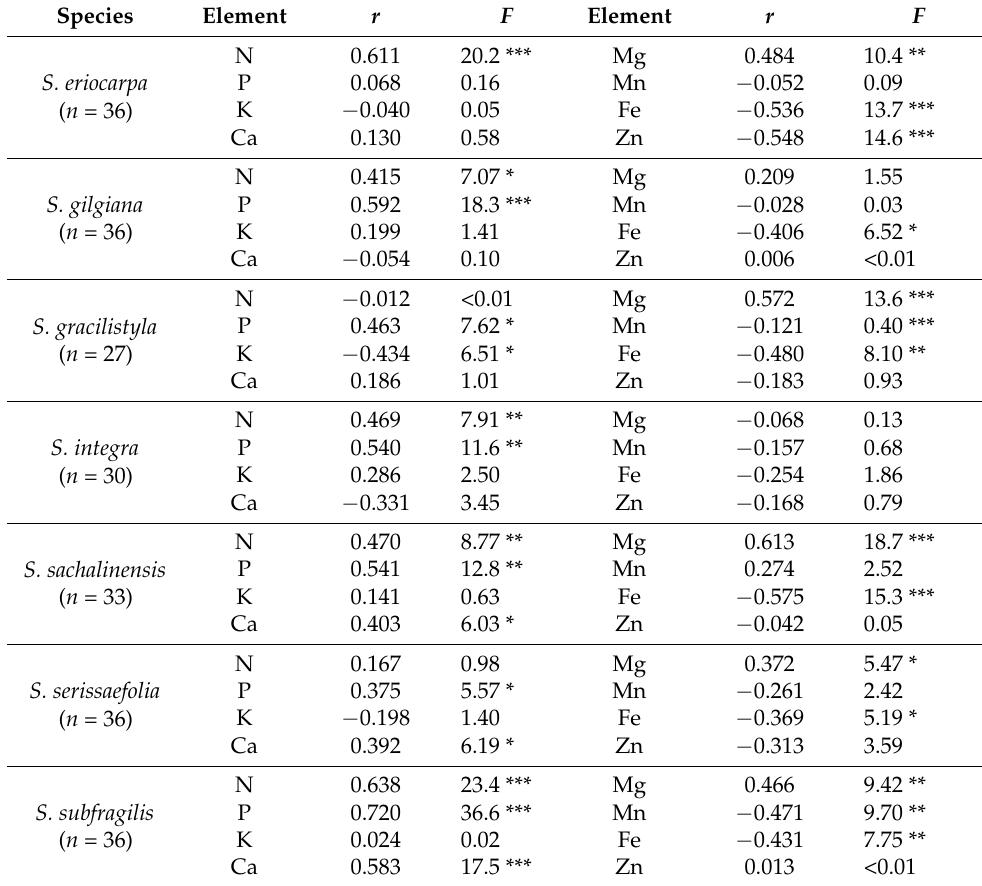
Table 8. Regression correlation coefficients between RHGR (dependent variable) and concentrations of elements in the leaves (independent variable) of willow